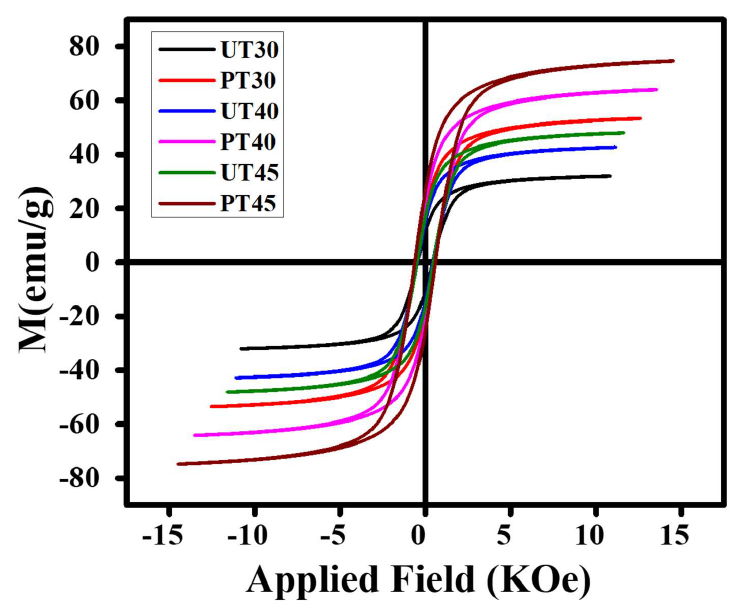
Figure 6. Variation in saturation magnetization, coercivity and remanence magnetization with plasma treatment.